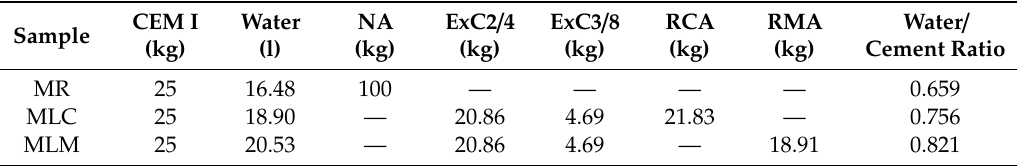
Figure 5. Final appearance of the mesh and formwork of the constructive unit. Table 5. Mortar dosages for the 70 L mixer